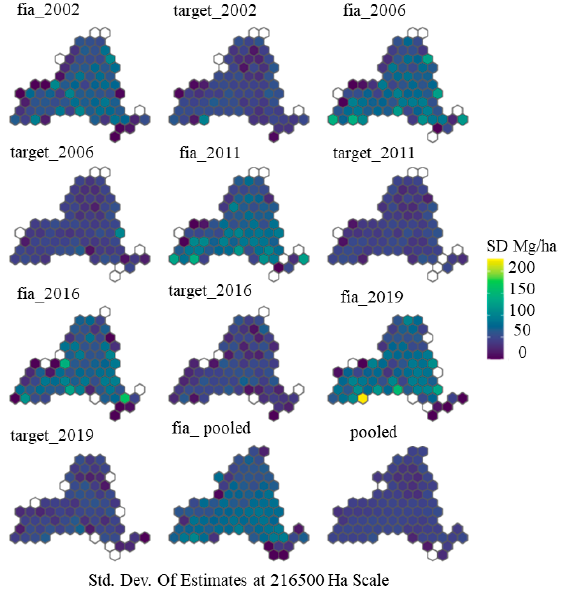
Figure 13. Mapped results of local variability of plot values in each 216,500 ha area (2002, 2006, 2011, 2016, 2019, and